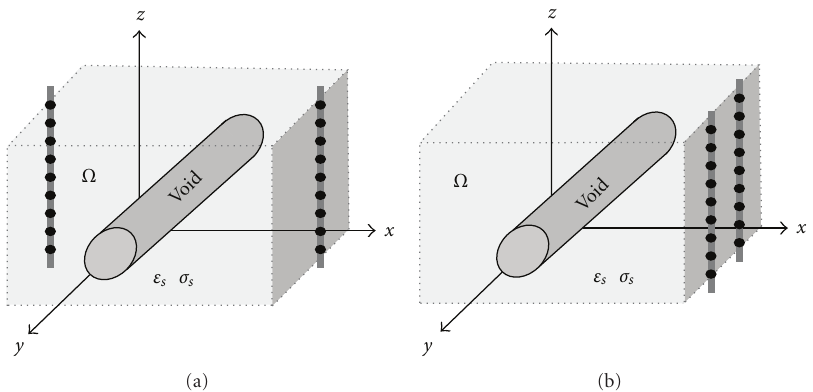
Figure 1: Reference scenario and the adopted measurement configurations. The volume Ω is the imaged region which is probed by antennas along the two boreholes: (a) cross-hole measurement setup and (b) reflection measurement